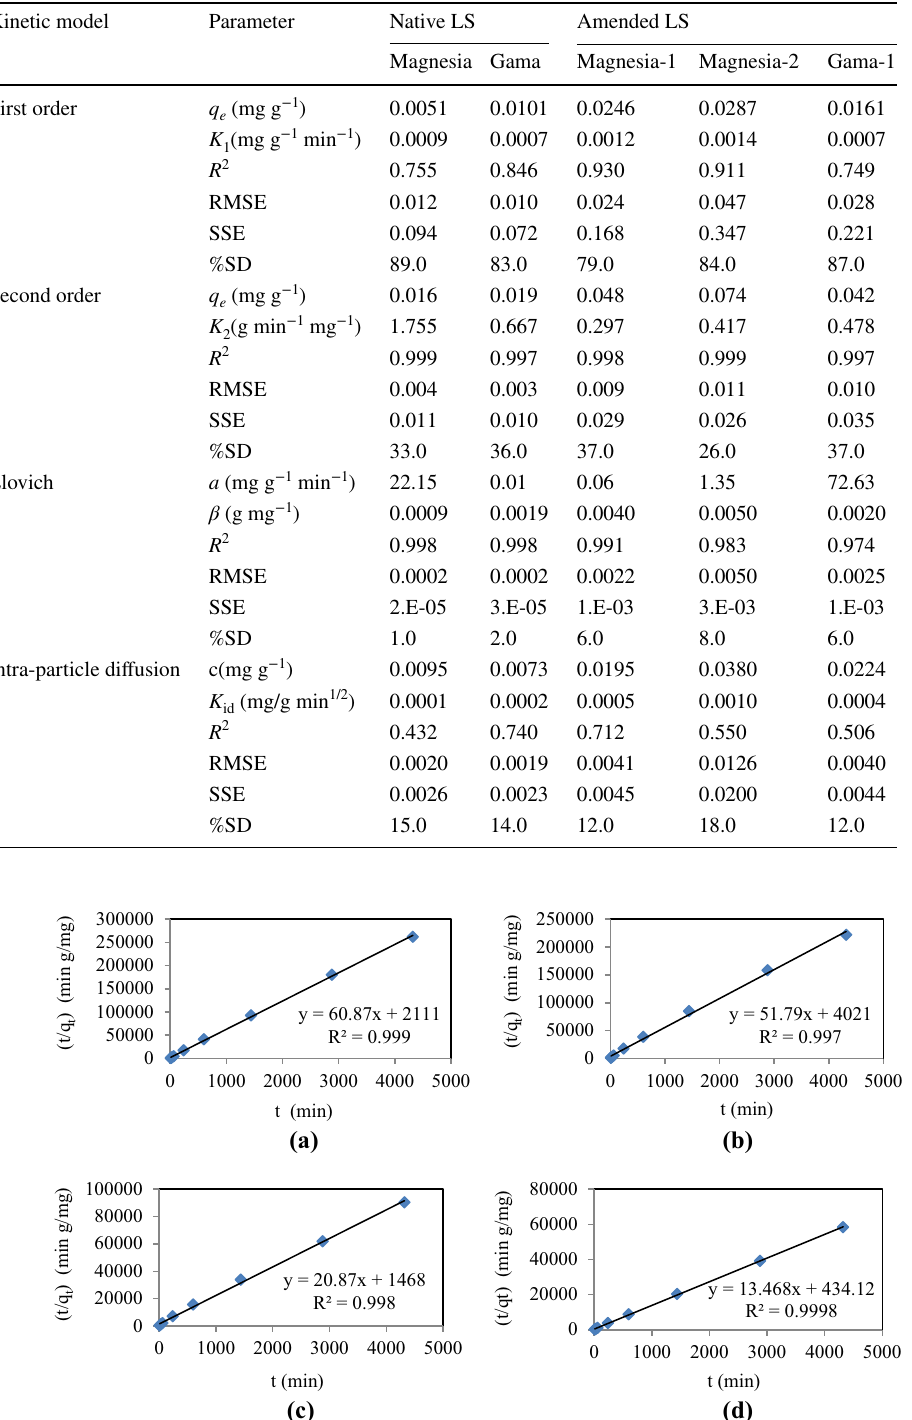
Table 4 Statistical parameters of kinetic models and their respective standard Error